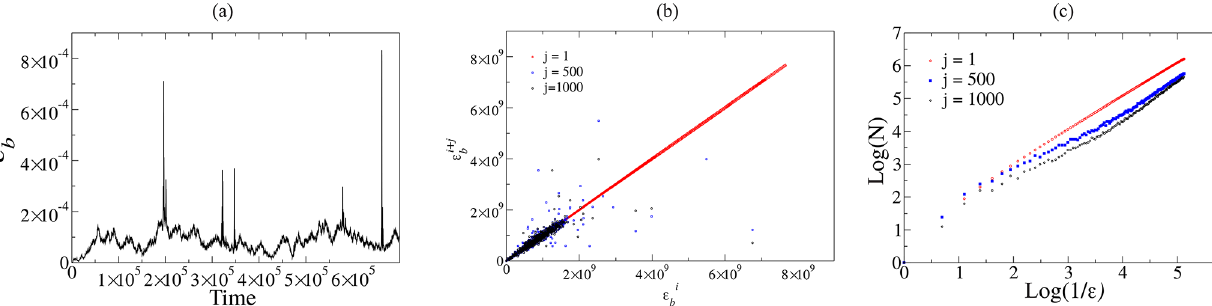
Figure 2. (a) (cid:15) b for the year 2000; (b) scatter diagram; (c) log–log plot of Eq. (7). Results for three values of the data sampling are shown: j = 1 (red points), j = 500 (blue points), and j = 1000 (black